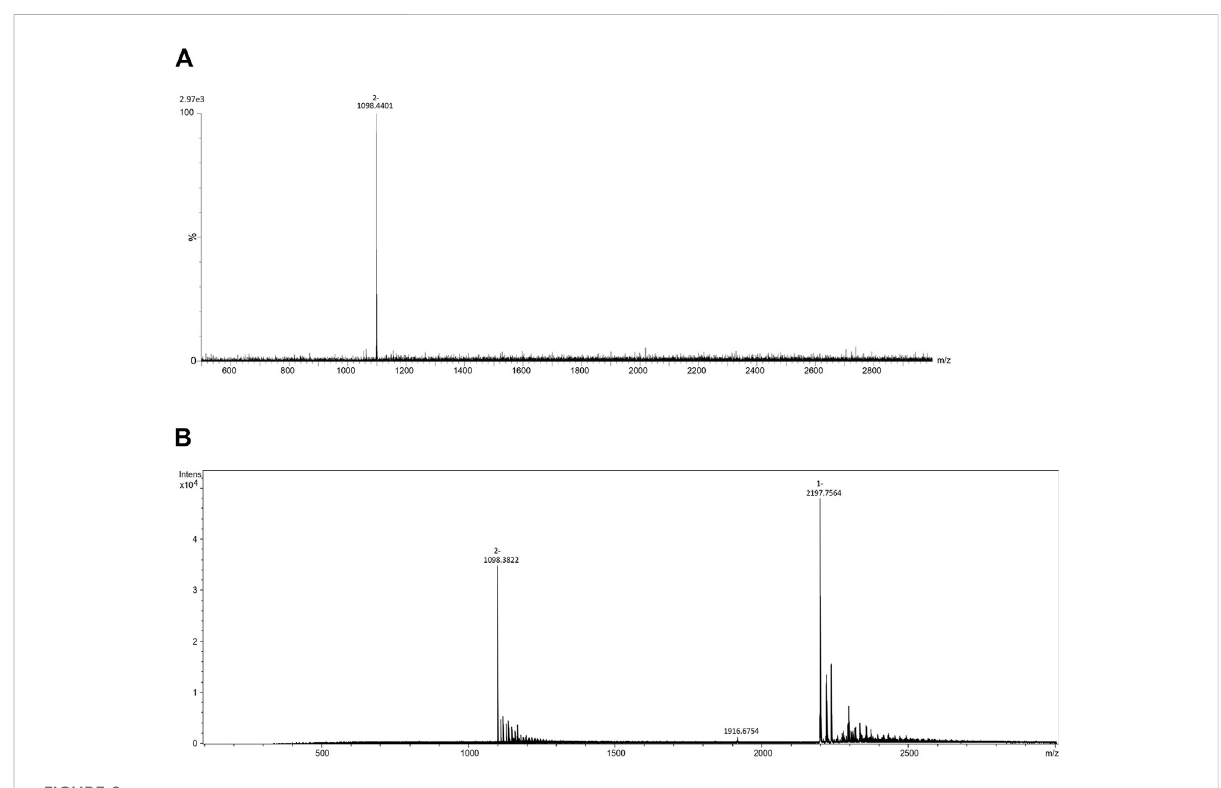
FIGURE 2 Representative sum spectra of 2AA labeled FA2G2S1 in (A) Lab1 and (B) Lab2.